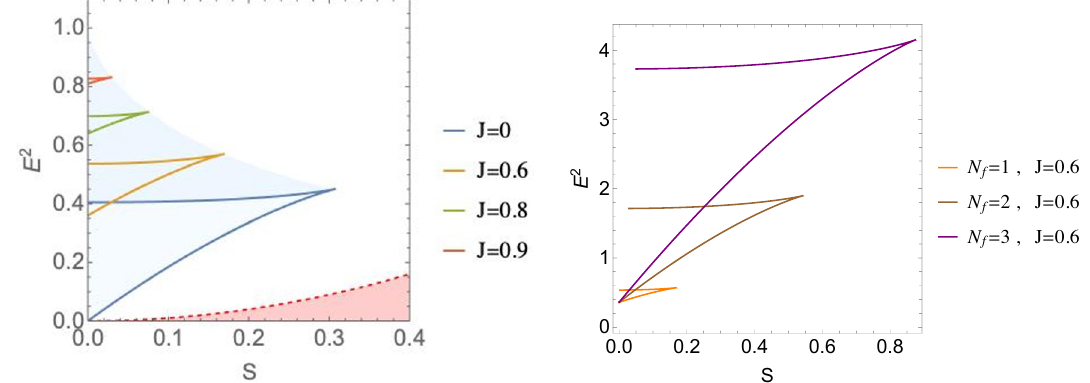
Figure 3 . The left panel shows Regge trajectories for N f = 1 with different internal charge J . The right panel shows Regge trajectories for different N internal charge J are in the units of R/α 0 , R 2 /α 0 and R 2 /α 0 , respectively. We find that the Regge trajectories always satisfy the Higuchi bound ( E 2 ≥ S ( S − 1)